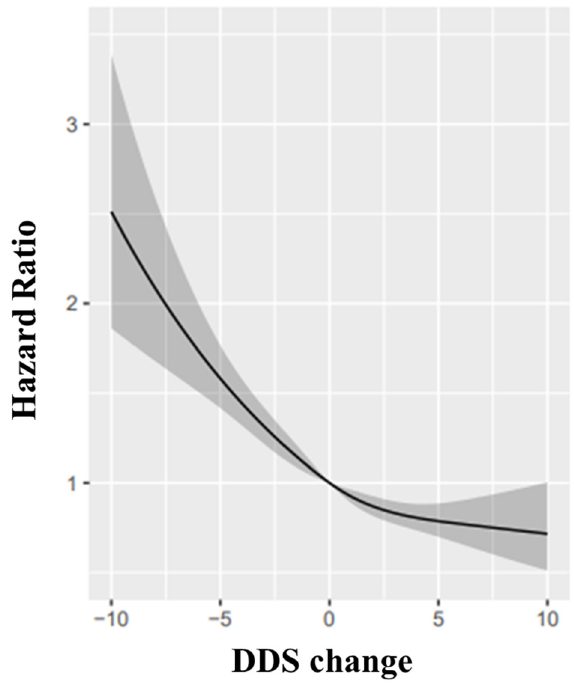
Figure 2. Restricted cubic splines for the association of DDS change with cognitive impairment: the reference point is the median value of DDS change (0), with knots placed at 10th, 50th, and 90th percentiles, after adjusting for age, sex, BMI, the number of teeth, use of artificial dentures, occupation, marital status, residence type, education level, living pattern; tobacco smoking, alcohol drinking status, ADL, regular exercise, hear diseases, diabetes, hypertension, digestive system diseases, cerebrovascular diseases and cancer, eye diseases, respiratory diseases, baseline MMSE. Hazard ratios were indicated as solid lines and 95% confidence intervals as grey parts. Table 6. The association between DDS change and the incidence of cognitive impairment.